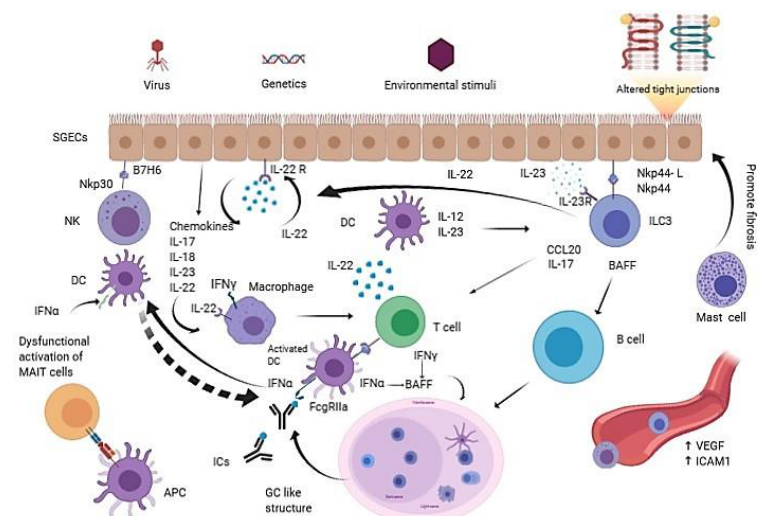
Figure 1. The interplay between innate immune cells and the inflammation prone microenvironment in Primary Sjogren Syndrome (pSS). pSS is a multifactorial rheumatic disease: environmental stimuli,